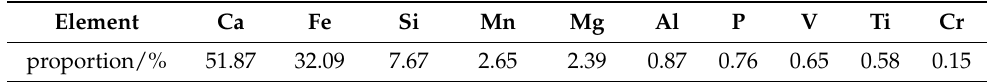
Table 1. The main element ratio of Shougang steel slag. Element